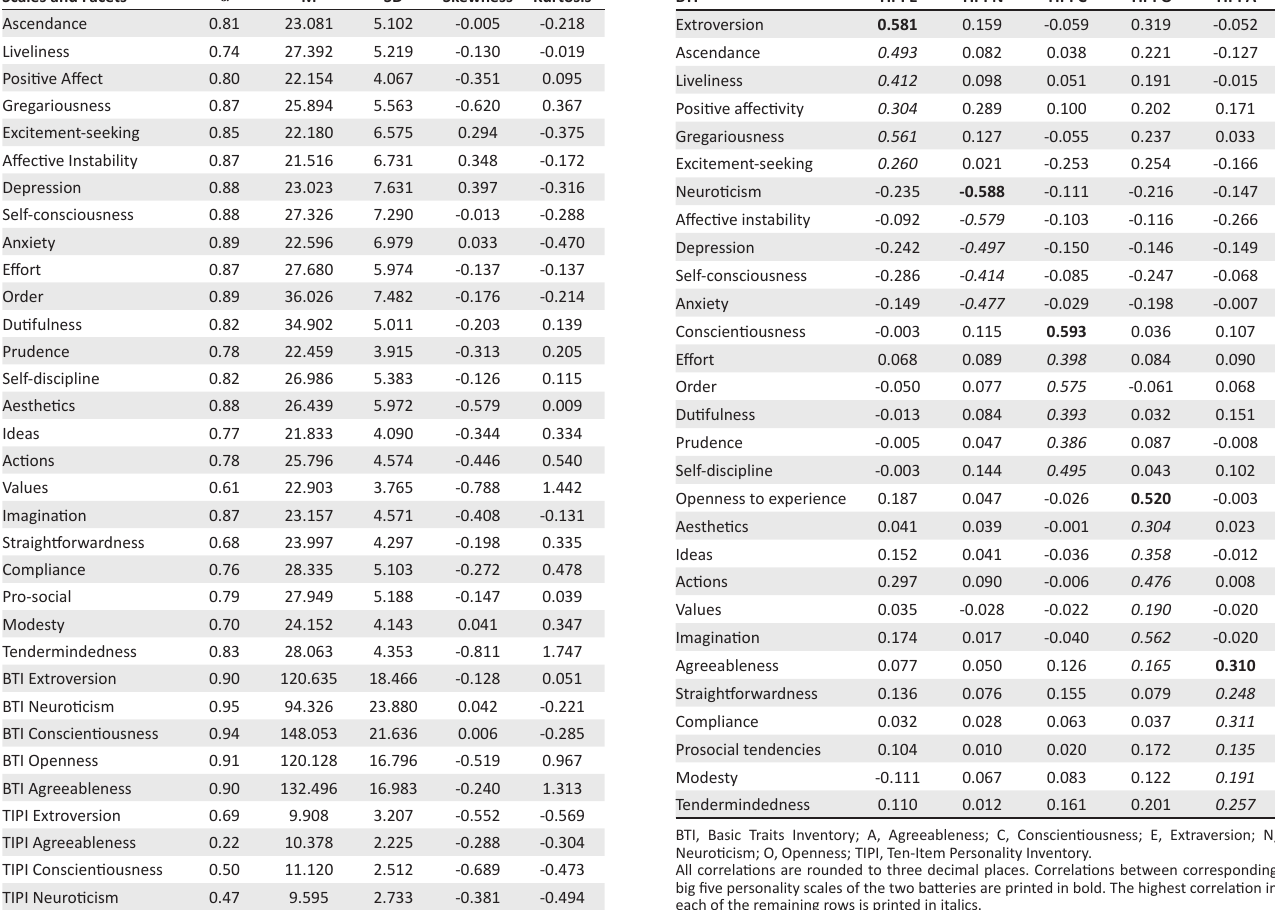
TABLE 2: Cross-battery correlations of the BTI and the TIPI.